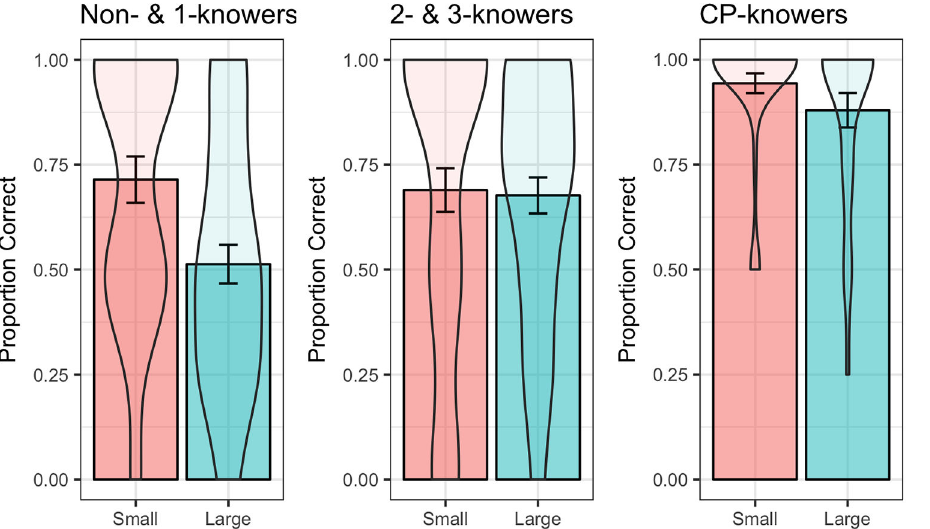
Figure 3. Overall proportion correct on small and large numerosity comparisons on incongruent trials, separated by knower- levels in Experiment 2. Only 2:3 ratio comparisons were included. Violin plots are used to depict the distribution and probability density of the data. Error bars represent standard errors of the